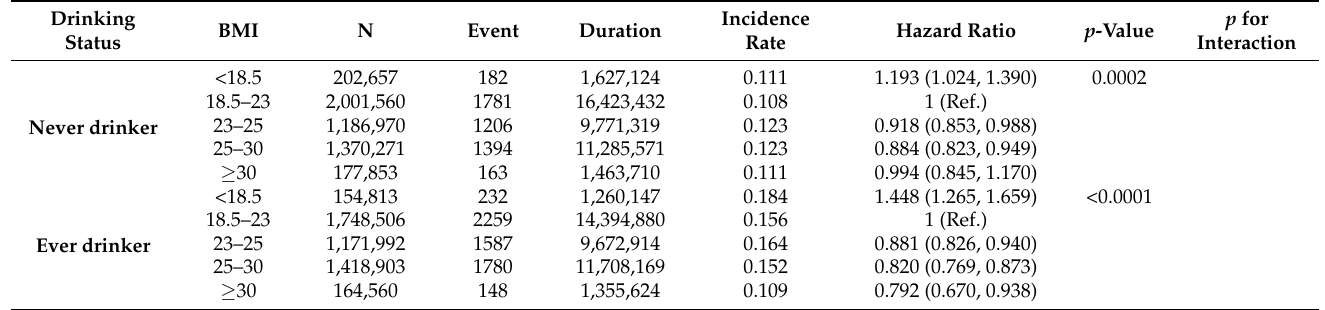
Table 5. Interactions analysis: body mass index with drinking on the occurrence of head and neck